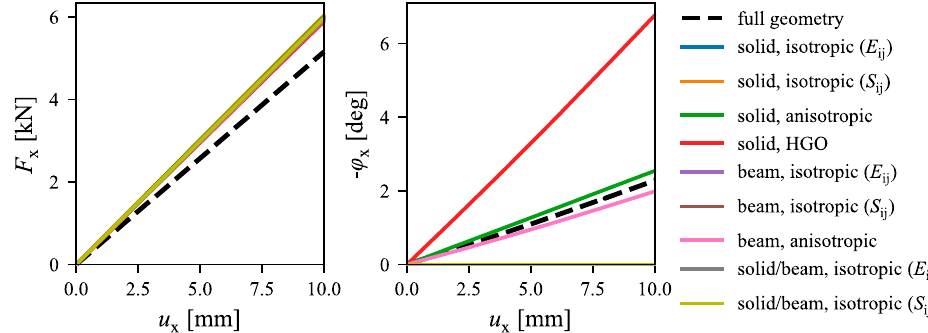
Figure 10. Force–displacement and end rotation–displacement plots of the three-cable szs-type specimen with free end rotation ϕ x .